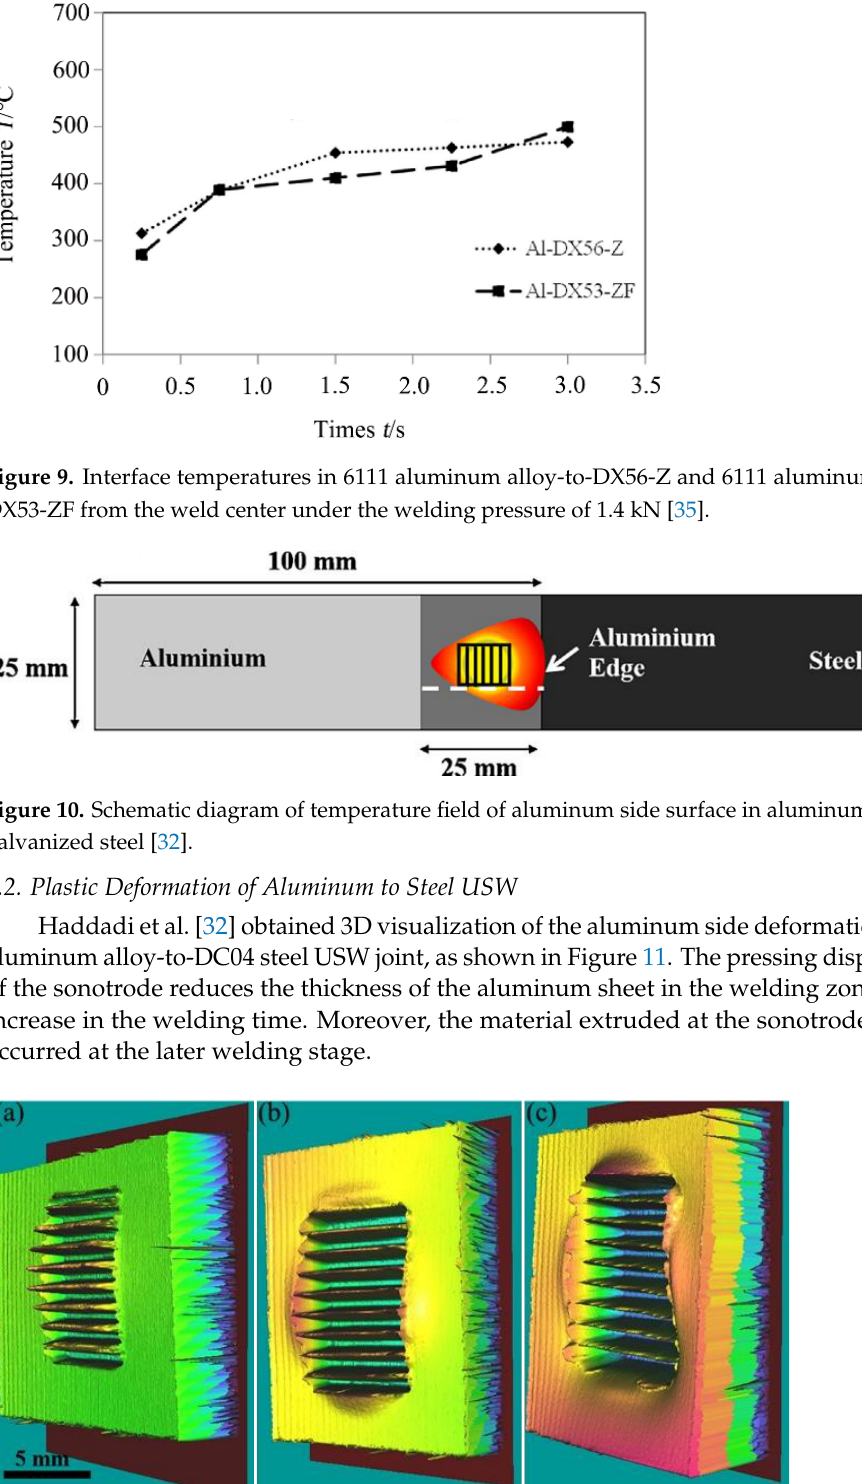
Figure 11. 3D presentation of sonotrode tip embedded Al with increasing welding times [32]: ( a ) 0.25 s; ( b ) 1.5 s; ( c ) 3.0 s.